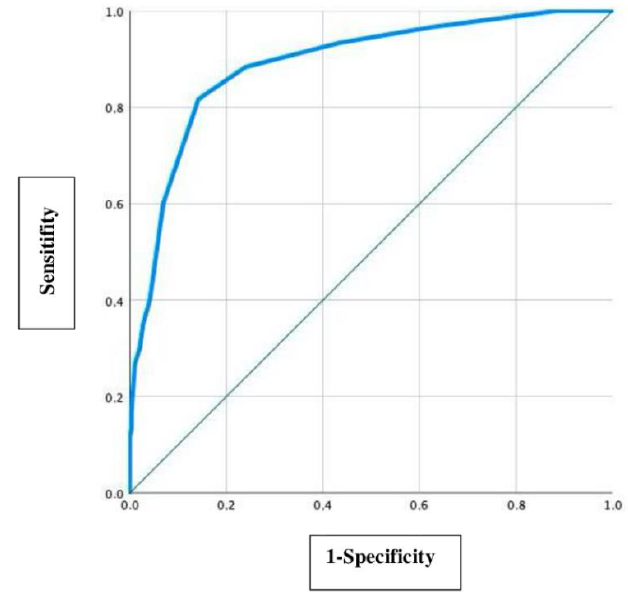
Figure 2. ROC curve to find the optimal MCA-PSV cut-off value.